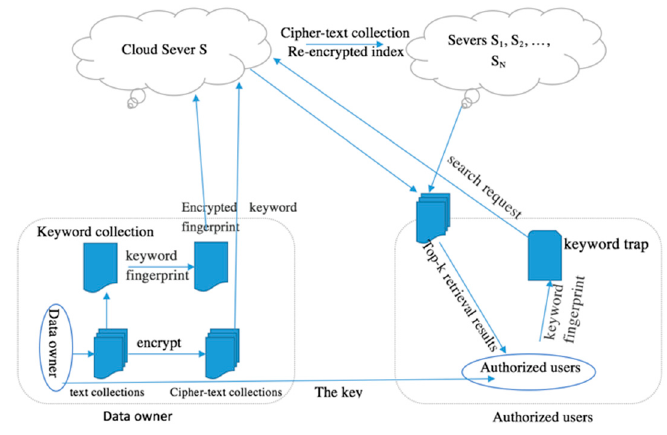
Figure 1. The system model.